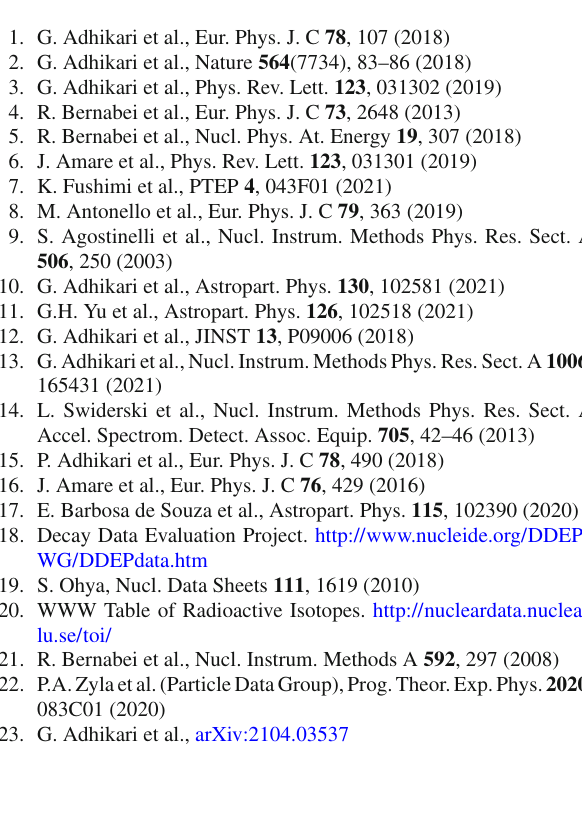
Fig. 9 Thelow-energyspectraofsingle-hiteventsaveragedforthefive crystals.Themeasuredenergyspectrumafterefficiencycorrections[23] is compared with the total of the simulations. The range of 1–6 keV in the MC spectrum is extrapolated from the modeling